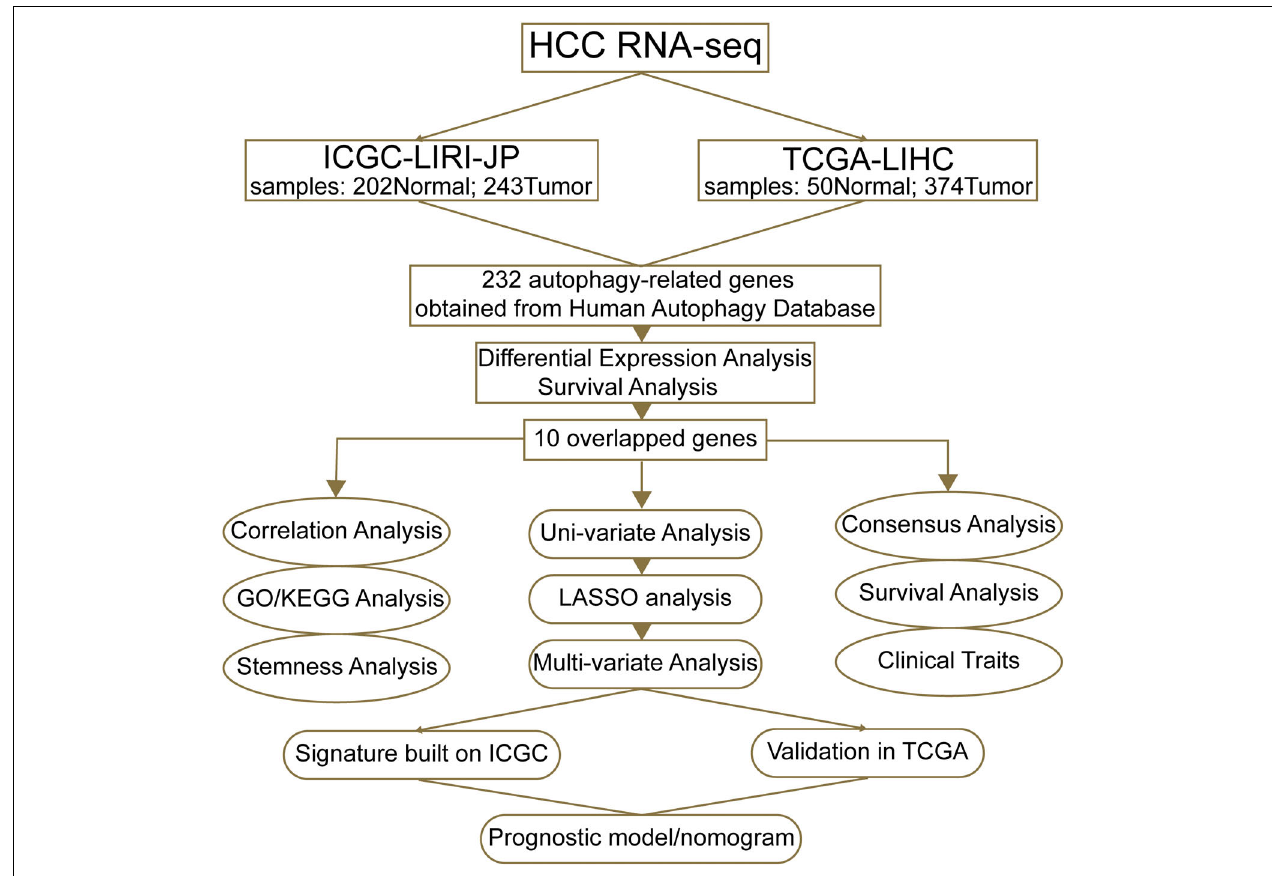
FIGURE 1 | A workflow of our current work. “ICGC-LIRI-JP” denotes that the liver cancer data of the ICGC database were obtained from RIKEN, Japan. “TCGA-LIHC” means that data of liver hepatocellular carcinoma were from TCGA